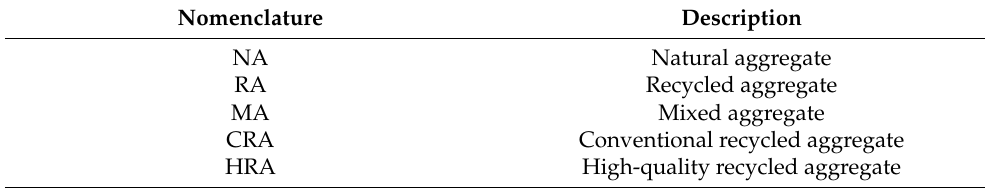
Table 4. Nomenclatures used for each aggregate